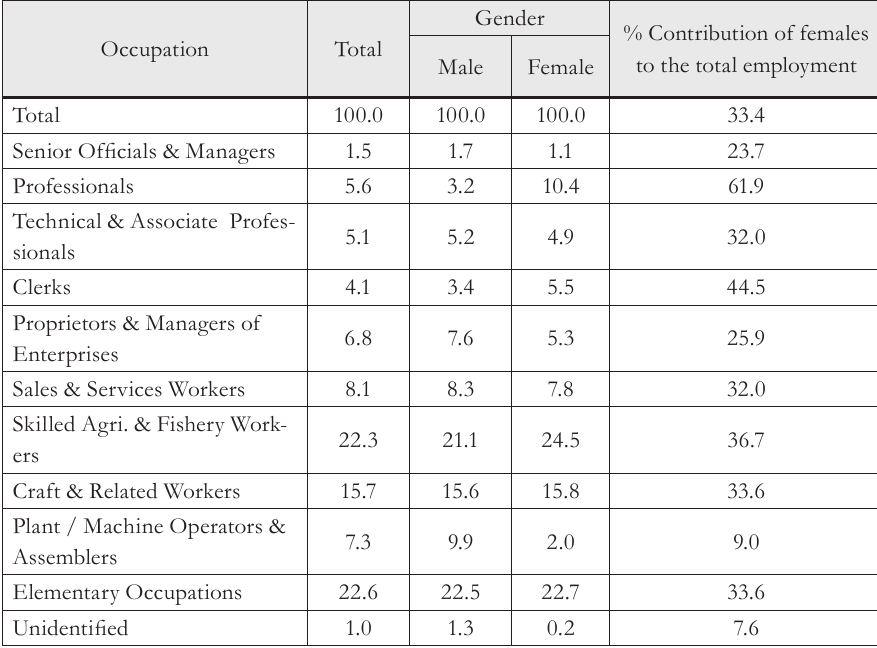
Tab. 3 - Employed population by Occupation. Source: Labour Force Survey - Annual Report